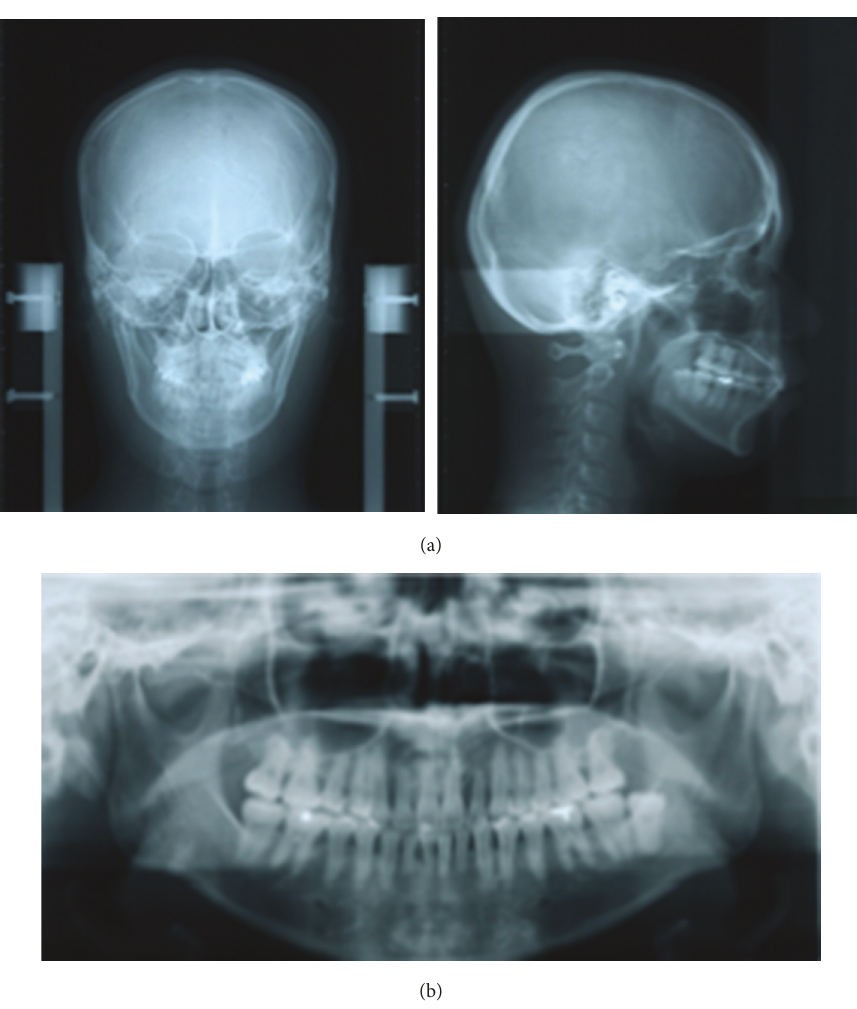
Figure 10: A post-retention cephalograms (a) and panoramic radiographs (b) are